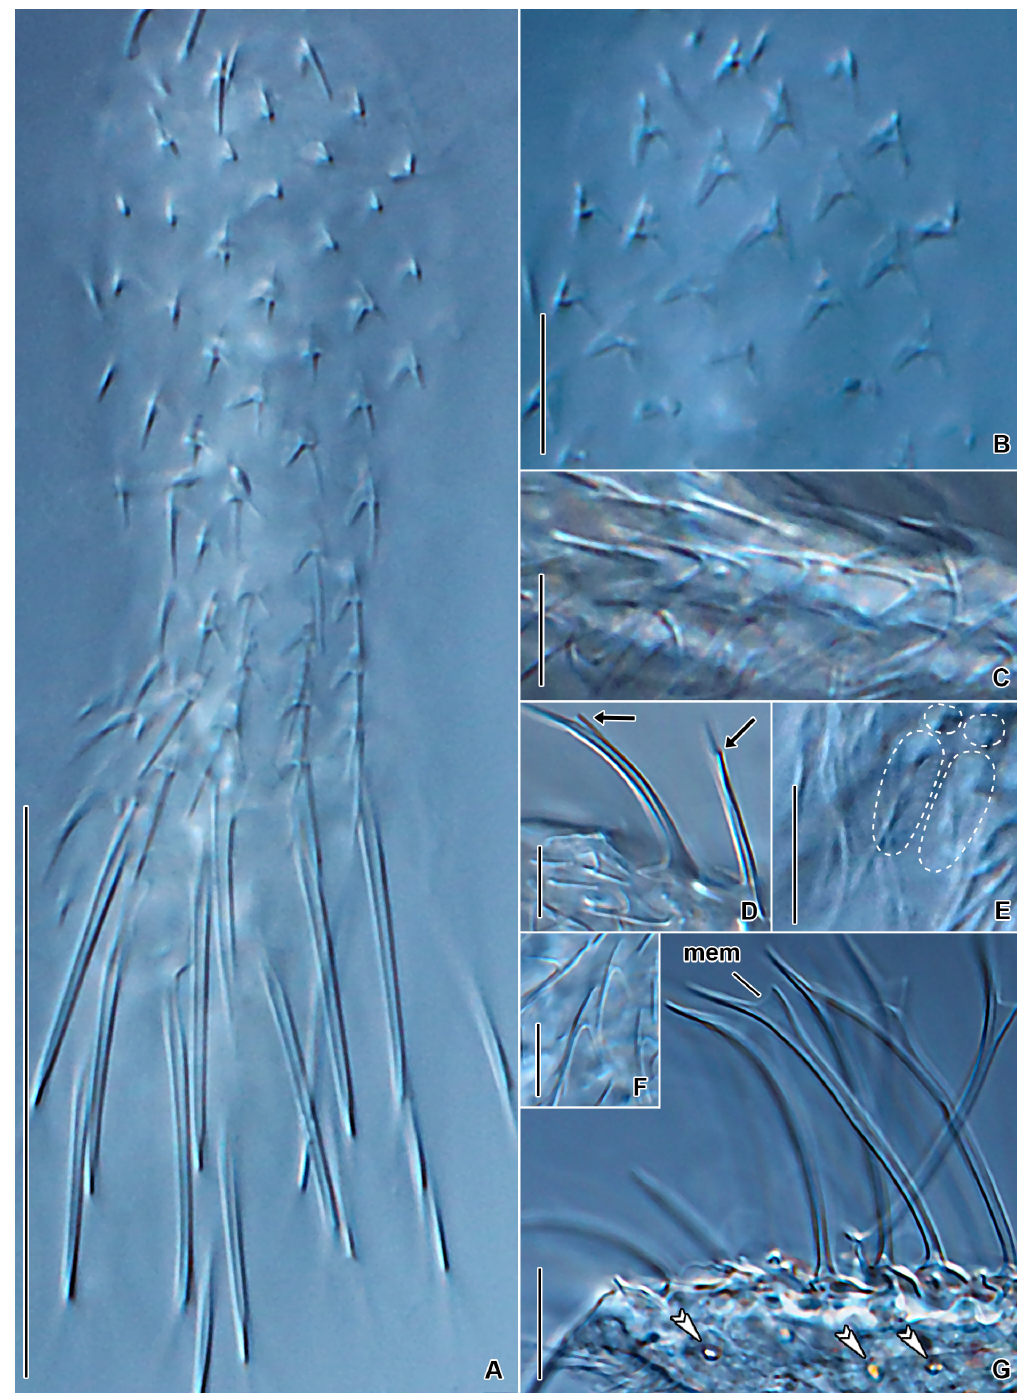
Fig. 14. Chaetonotus ( Hystricochaetonotus ) mirabilis sp. nov., differential interference contrast. A–B, E . Paratype (CU-FNS-25-10-19/PA-1). C–D, F–G . Paratype (CU-FNS-02-10-19/PA-2). A . Dorsal view showing the scale and spine pattern. B . Head scales. C . Neck and upper trunk dorsolateral scales. D . Terminal dorsal trunk scales with a lateral denticle (arrows). E . Ventral ciliary bands. White dashed lines mark upper-furcal scales. F . Lateral trunk scales. G . Dorsal trunk spines with a membrane. White double arrowheads mark the highly refractive bodies in the intestine. Scale bars: A = 30 µm; B–F = 5 µm; G = 10